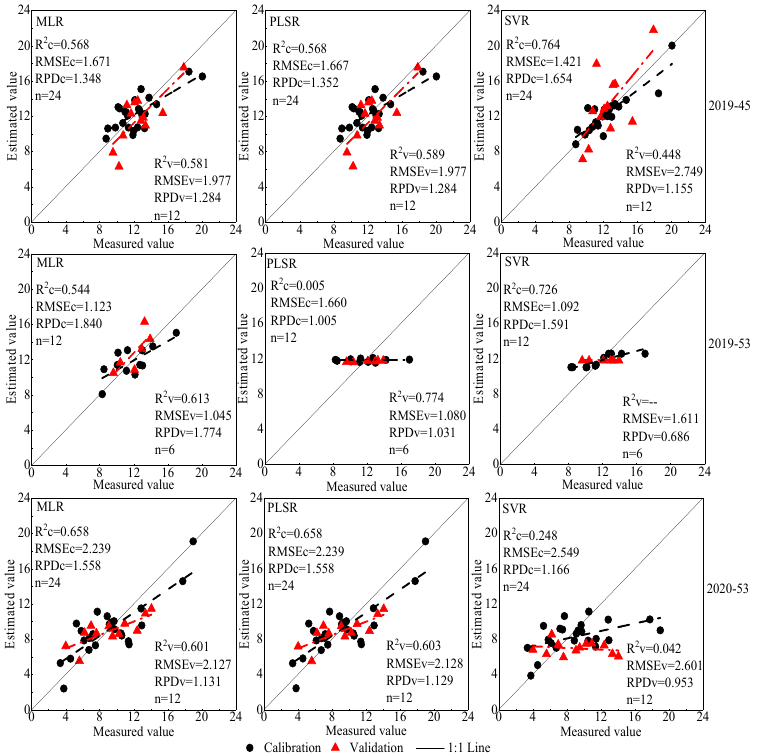
Figure 10. Parameters of CND estimation and verification model of drip ‐ irrigation cotton at flowering and boll stage based on vegetation index. According to the establishment of the CND estimation model in the full ‐ boll period of drip ‐ irrigation cotton (Figure 11), the R 2 value of the estimation and verification model was the highest and the most stable. The R 2 c and R 2 v values were 0.558 and 0.600, and RPDc and RPDv were 1.348 and 1.284, respectively. In the full ‐ boll period, the modeling effects of PLSR and SVR did not show advantages, and overfitting occurred in the CND estimation by SVR in four growth stages.